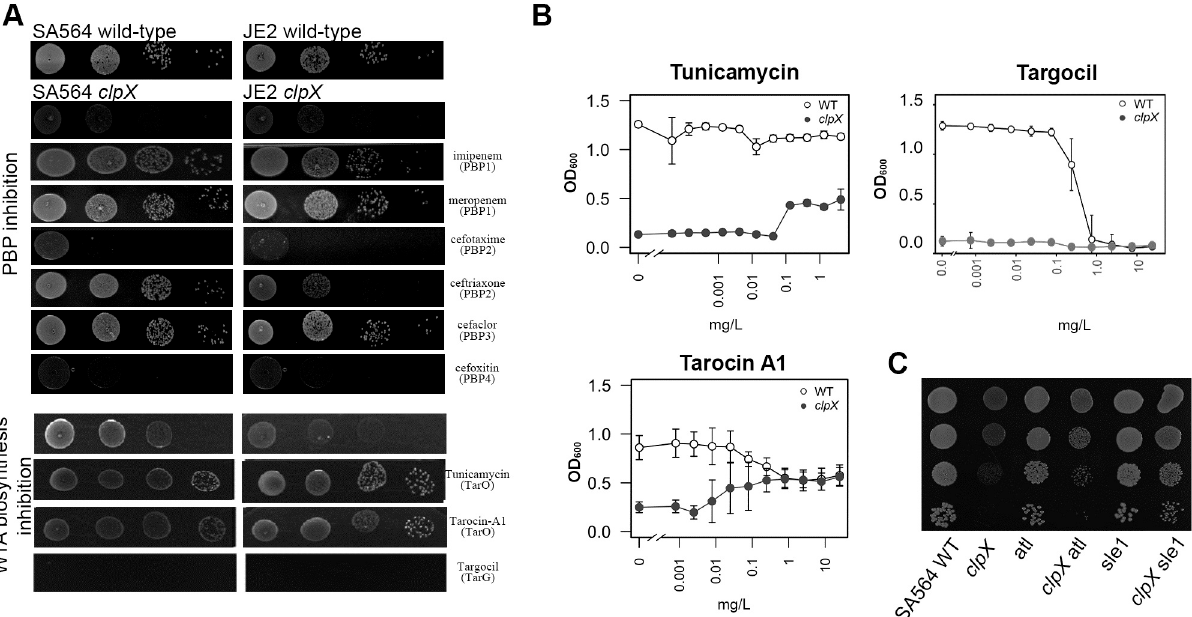
Fig 7. β -lactam antibiotics targeting PBP1or BPB3, and WTA (TarO) inhibitors specifically promote growth of the clpX mutant. ( A) The S . aureus wild-type strains, SA564 (MSSA) and USA300 JE2 (MRSA) and the clpX deletion strains derived here from were grown exponentially in TSB at 37˚C. At OD 600 = 0.5, cultures were diluted 10 1 , 10 2 , 10 3 and 10 4 -fold, and 10 μ l of each dilution was spotted on TSA plates in the presence or absence of subinhibitory concentrations (1/5 MIC of wild-type) of β -lactams with different PBP specificities as indicated; the TarO inhibitors tunicamycin (0.5 ug/ ml), and tarocin A1 (0.5 ug/ml), or the TarG inhibitor, targocil (0.2 ug/ml), and incubated at 30˚C for 24 h. ( B ) S . aureus SA564 wild type and the clpX deletion strains were grown overnight at 37˚C, diluted 1:200 and grown at 37˚C until mid-exponential phase. These cultures were then diluted into TSB alone (control) or containing increasing concentrations of tunicamycin, tarocin A or targocil in a 96-well format, and the plates were incubated for 24 h at 30˚C. The average final OD and standard deviations from three biological replicates were plotted. ( C ) The S . aureus SA564 wild-type strain, and the indicated mutant strains were grown exponentially in TSB at 37˚C. At OD 600 = 0.5, cultures were diluted 10 1 , 10 2 , 10 3 and 10 4 -fold, and 10 μ l of each dilution was spotted on TSA plates and incubated at 30˚C for 24 h.